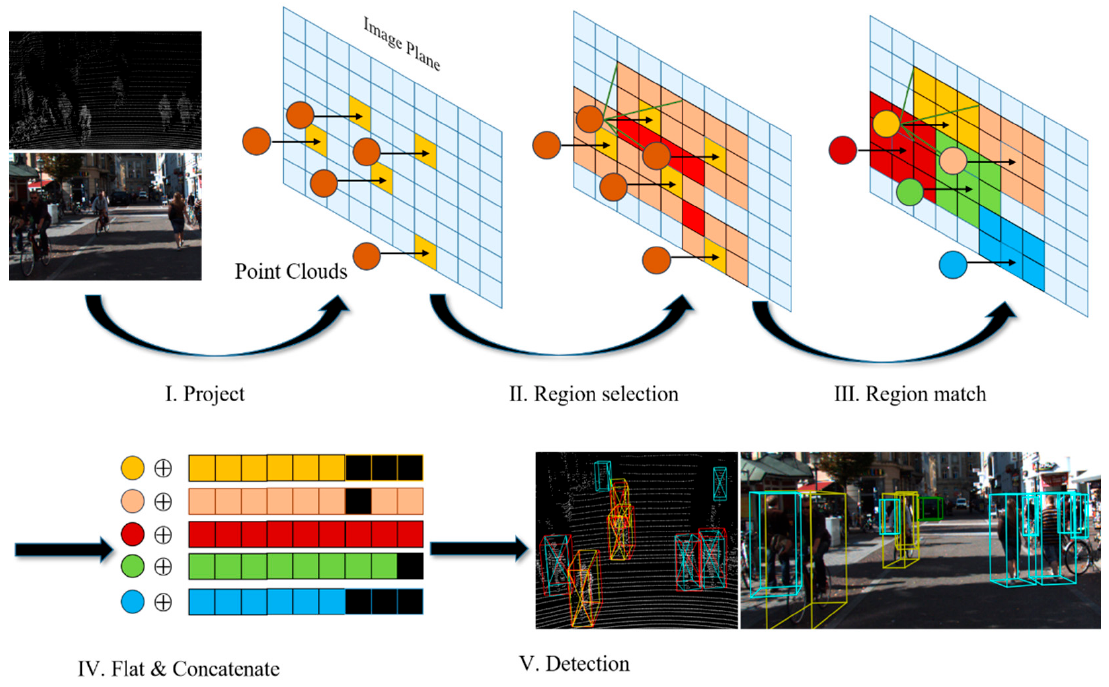
Figure 1. PMPF overview. The PMPF architecture consists of the following five stages: (I) point cloud project to image plane, (II) region selection, (III) region match, (IV) flat and concatenate, and (V) LiDAR-based detector. In the first stage, the point cloud is projected onto the image plane to obtain the pixels corresponding to each point. In the second stage, the region corresponding to each point is selected using the corresponding pixel as the key pixel. In the third stage, the region corresponding to each point is selected precisely by matching. In the fourth stage, the regional point cloud data is flat and fused with the point cloud. Finally, the LiDAR-based object detector can be used on this decorated point cloud for 3D detection.